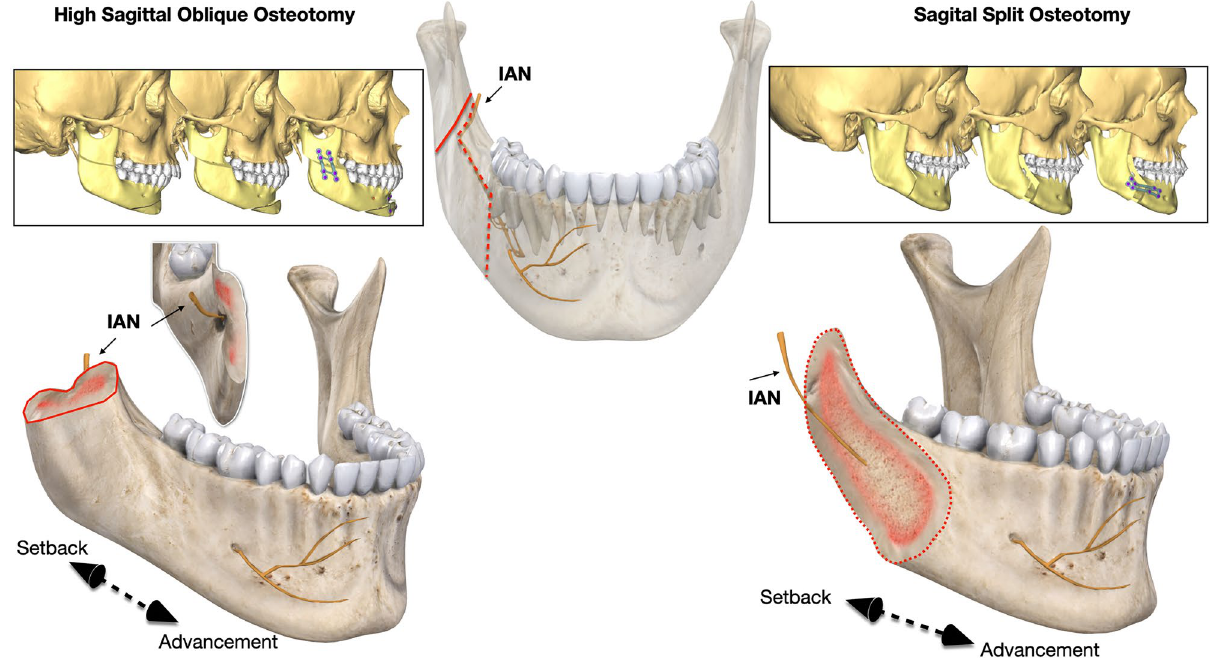
Figure 1. Schematic comparison of high sagittal split osteotomy (HSOO, left) and bilateral sagittal split osteotomy (BSSO,